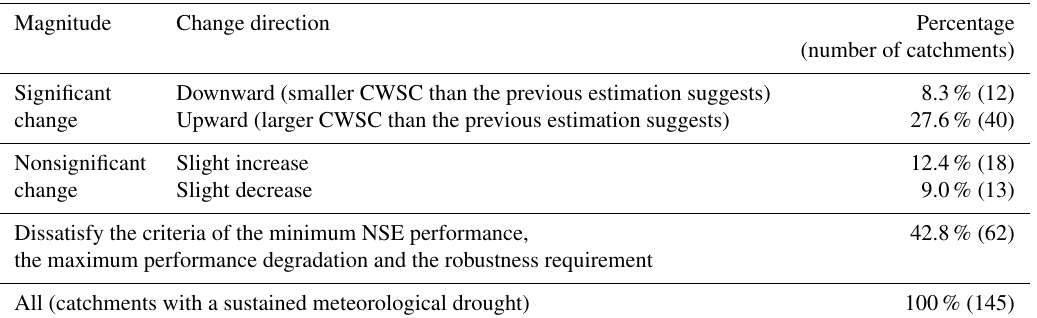
Table 3. The direction of the shifts in the CWSC due to the long-term meteorological drought for the catchments in southeastern Australia. NSE: Nash–Sutcliffe